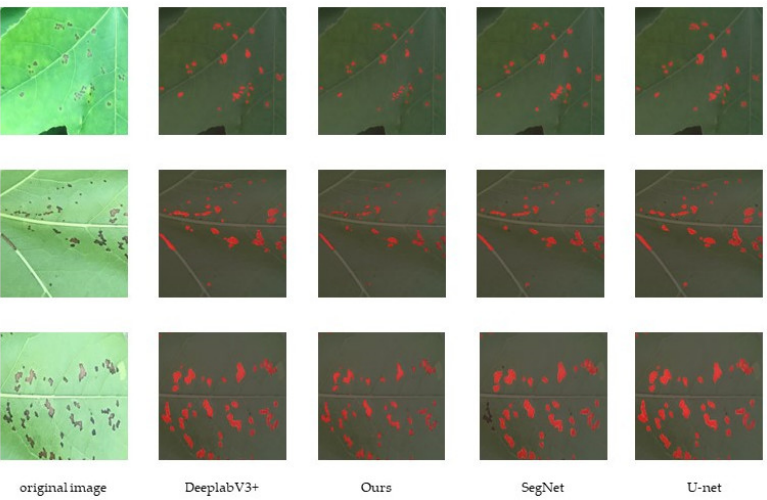
Figure 12. Comparison diagram of the segmentation effect.